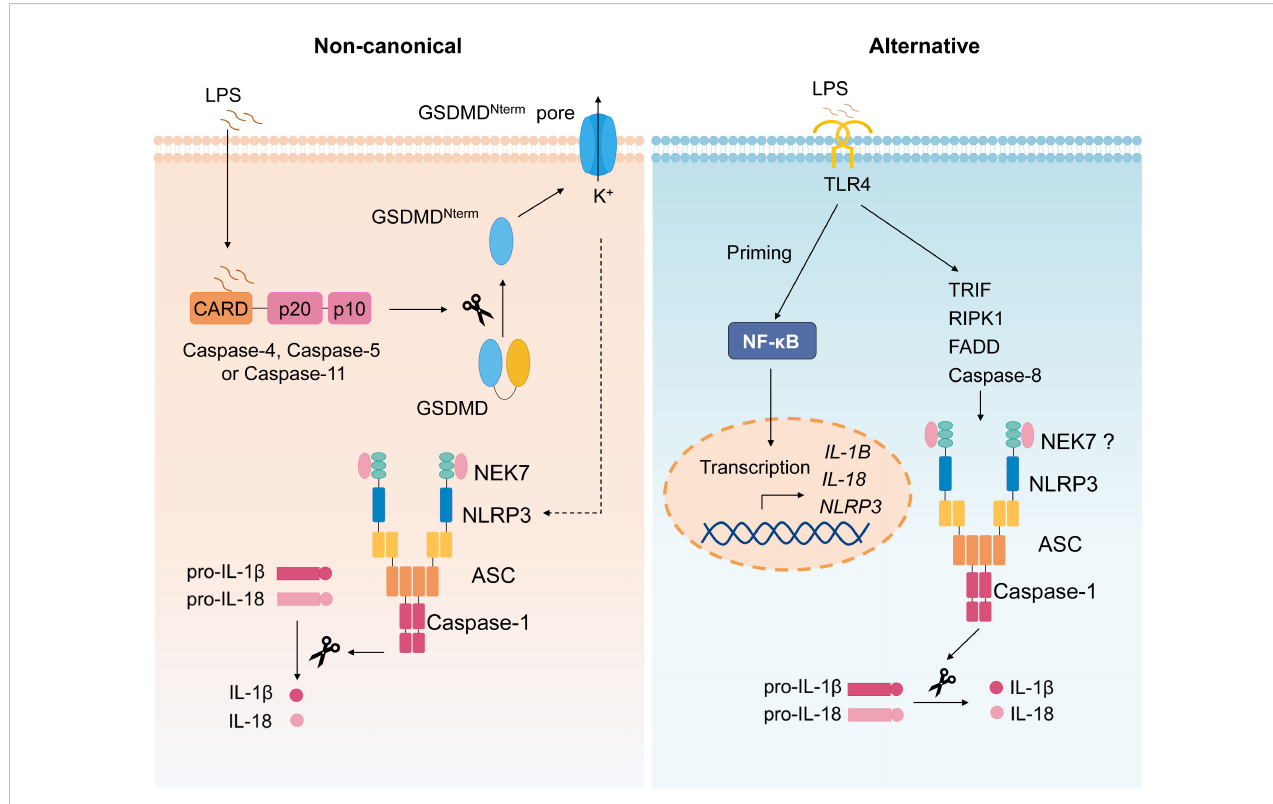
FIGURE 3 Non-canonical and alternative in fl ammasome. Non-canonical in fl ammasome activation is triggered by caspase-4/5/11 activation upon recognition of intracellular LPS, followed by cleavage of GSDMD and subsequent pyroptosis, causing the potassium ef fl ux, which then induces canonical NLRP3 in fl ammasome. The alternative NLRP3 in fl ammasome activation refers to the signal 1 only in fl ammasome response. In monocytes, TLR ligands alone trigger IL-1 b secretion via TLR4-TRIF-RIPK1-FADD-CASP8 signaling upstream of